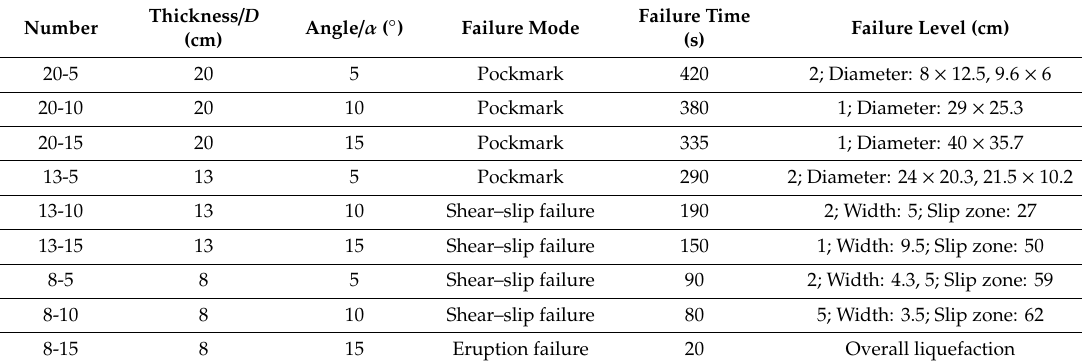
Table 3. Detailed information on the mode and degree of slope